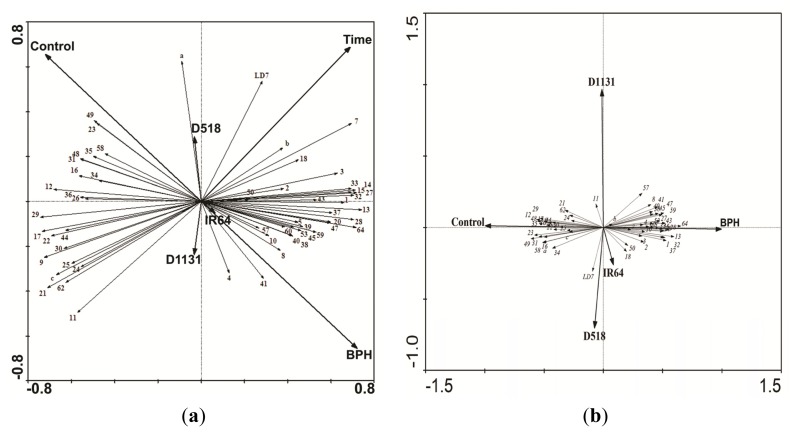
Redundancy analysis (RDA) biplot of protein abundance over the duration of the experiment. All factors are illustrated as thick vectors and include Control, Treatment (BPH infested), Loss of resistance (D1131), Gain of Resistance (D518), Wild type (IR64), and Time. Proteins are illustrated as thin vectors and consist of the proteins levels which are listed as a number as described in Table 2. Eigen values (lambda) are 0.324, 0.050, 0.010, and 0.004 using data at T3 (a) and all 4-time points (b) Monte Carlo test (1000 permutations) for all canonical axes: F-ratio = 8.490, P = 0.001.